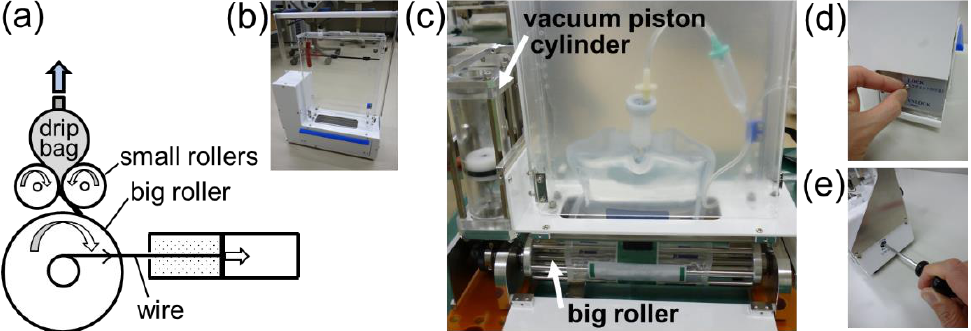
Figure 5. Prototype FIX-ROLLER. ( a ) A vacuum piston cylinder, whose actual orientation (vertical position) is shown in ( c ), pulls and rotates a rolling mechanism by a wire. ( b ) An exterior view of the prototype. ( c ) An interior view of the prototype mounted with a drip bag. ( d ) The rolling mech- anism is locked at the standby position by an interior-mounted rachet gear tooth (not visible in ( c )). The rolling mechanism is unlocked by turning a toggle switch at the exterior side panel. ( e ) The rolling mechanism is reset to the standby position using a hexagonal wrench.